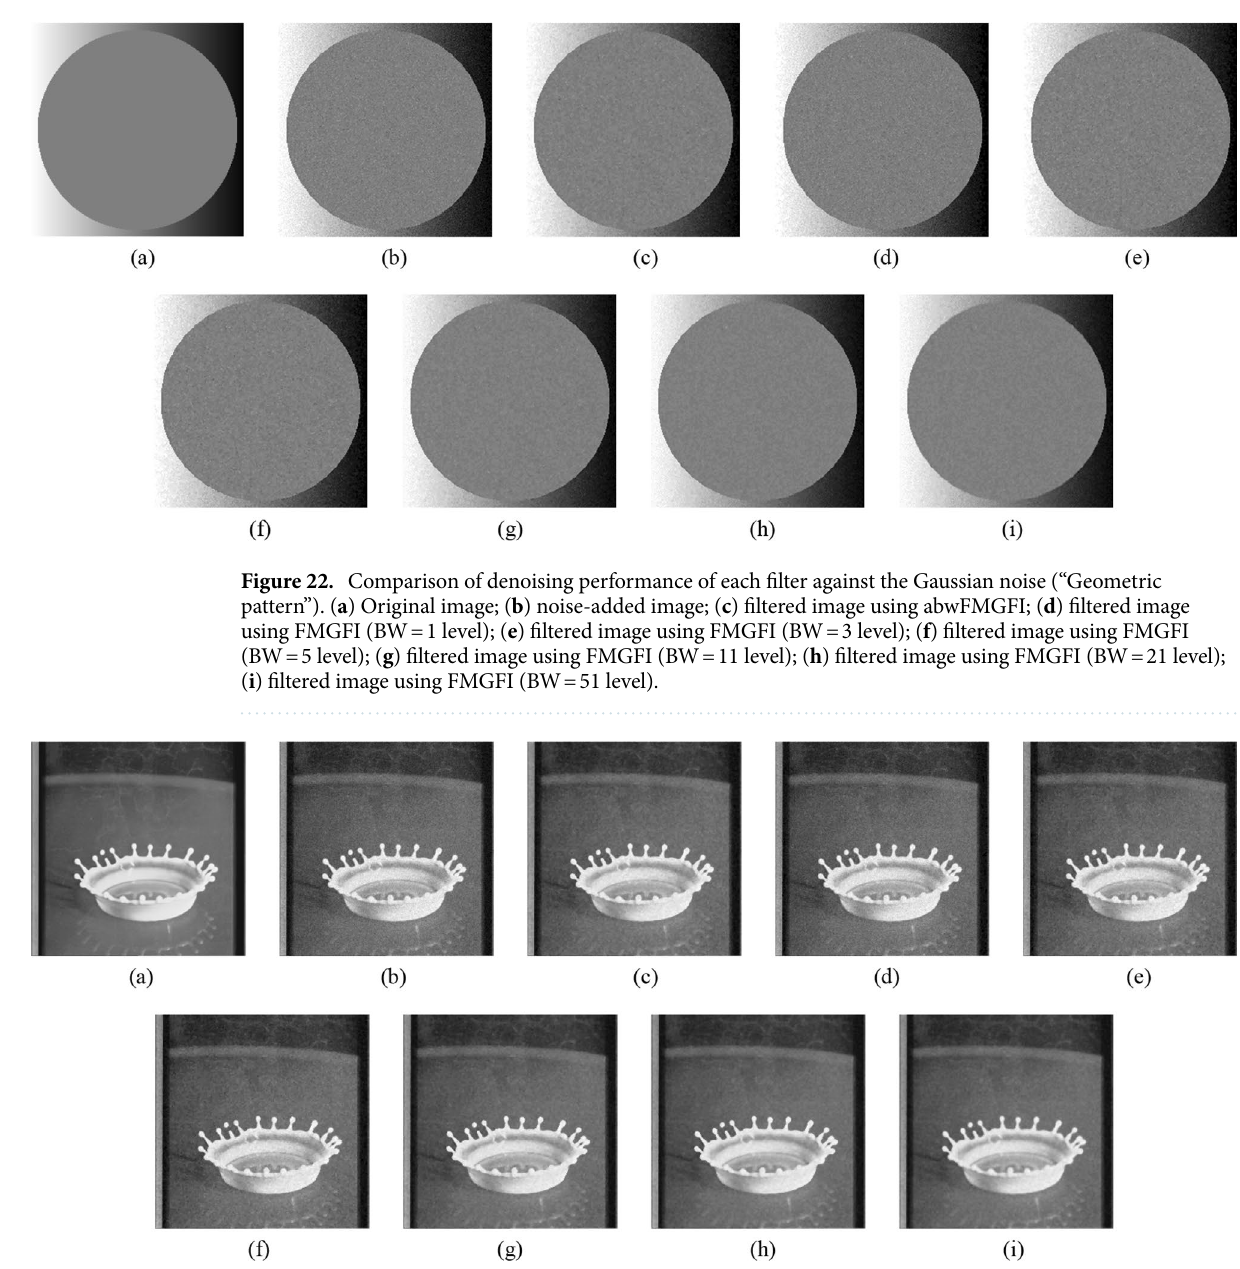
Figure 23. Comparison of denoising performance of each filter against the Gaussian noise (“Milkdrop”). ( a ) Original image; ( b ) noise-added image; ( c ) filtered image using abwFMGFI; ( d ) filtered image using FMGFI (BW = 1 level); ( e ) filtered image using FMGFI (BW = 3 level); ( f ) filtered image using FMGFI (BW = 5 level); ( g ) filtered image using FMGFI (BW = 11 level); ( h ) filtered image using FMGFI (BW = 21 level); ( i ) filtered image using FMGFI (BW = 51